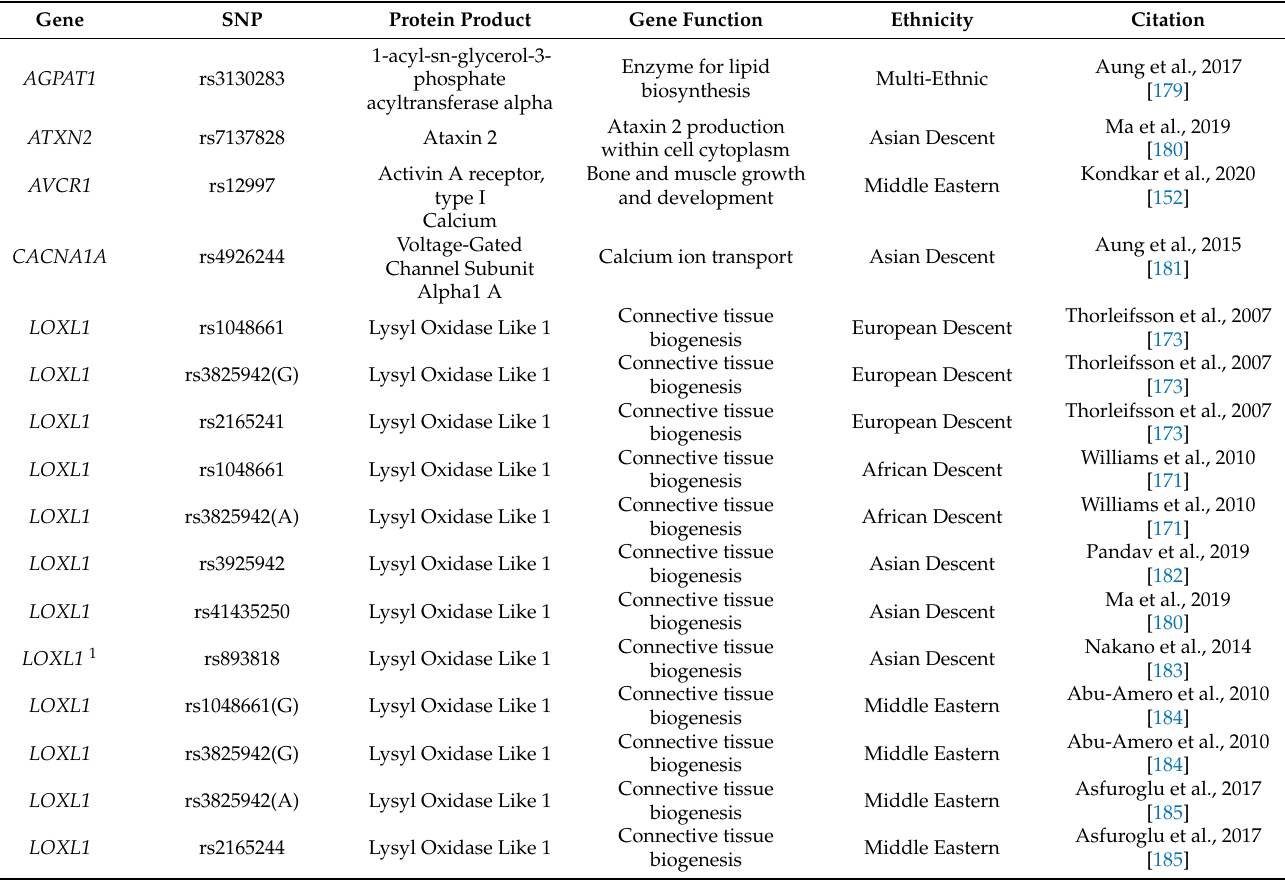
Table 3. Genes associated with exfoliation (pseudoexfoliation) glaucoma. SNP: single nucleotide polymorphism.